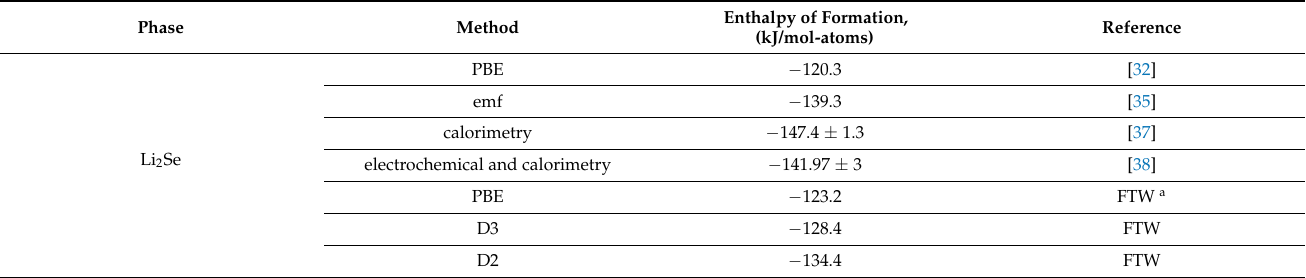
Table 2. The calculated enthalpies of formation of compounds in the Li-Se and Na-Se binary systems in this work compared with the experimental data from References